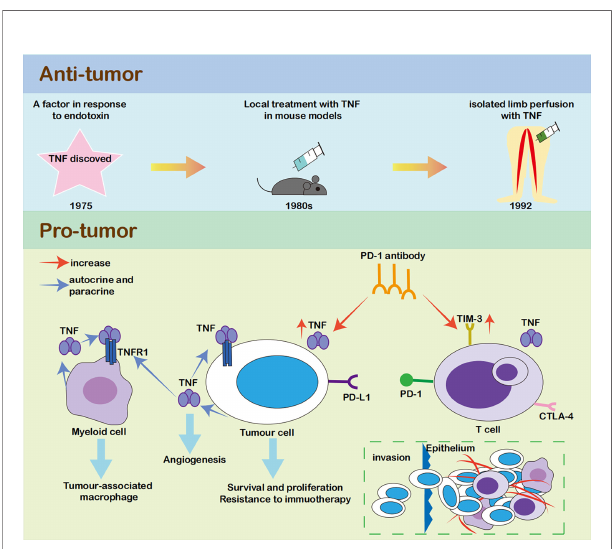
FIGURE 2 | The relationship between TNF and tumour. TNF was fi rst discovered as an anti-tumour factor (28). However, it mainly caused major destruction of the vascular bed rather than killing the malignant cells directly, and its clinical ef fi cacy was limited (29, 32, 33). In recent years, growing evidence showed that both cancer cells and tumour microenvironment produce TNF in an autocrine or paracrine manner. In malignant cells, TNF could cause DNA damage, help survival and proliferation (17, 38). In myeloid cells, TNF led to the generation of tumour-associated macrophage phenotype, which was associated with immune escape and tumour promotion (39, 40). In tumour microenvironment, continuous low concentrations of TNF contributed to angiogenesis, which promoted primary tumor growth and metastases, leukocyte in fi ltration, and pleural effusion (34, 41). TNF could also induce resistance to chemotherapy (42).